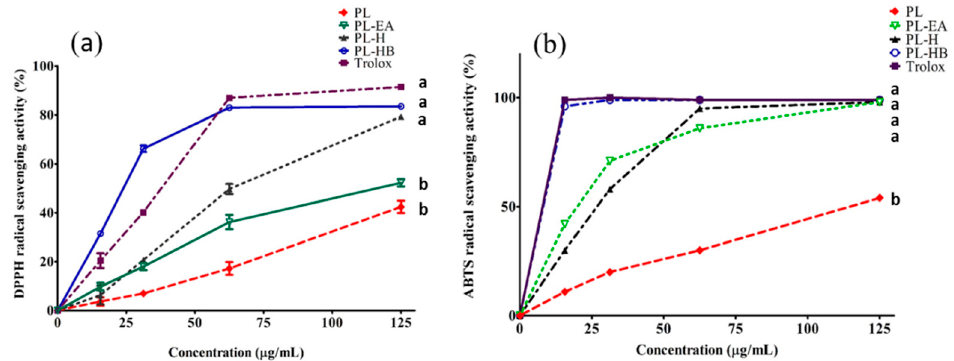
Figure 2. Radical scavenging capabilities of different preparations fractionated from P. linteus mycelia. ( a ) for DPPH radicals. ( b ) for ABTS + radicals. PL: 75% methanol crude extract. PL-EA: ethyl acetate fraction. PL-H: CPC isolated hispidin. PL-HB: CPC isolated hypholomine B and hypholomine B isomer. Data are expressed as mean ± SD from triplicate experiments. Different letters in lower case on each curve indicate significantly different from each other ( p < 0.05).